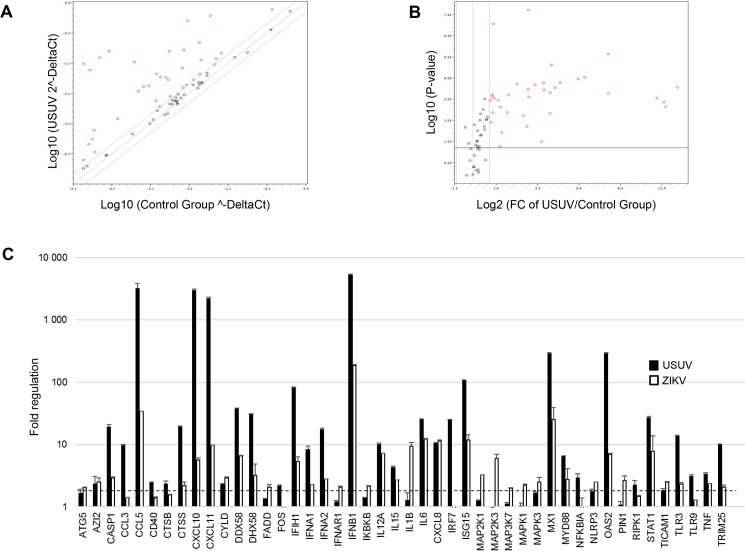
Anti-viral responses in USUV- and ZIKV-infected human astrocytes.mRNA from supernatants of primary human astrocytes infected with USUV or ZIKV at MOI = 1 for 3 days were subjected to qRT-PCR analyses. (A) Scatter plot. Up regulated genes appears in the top-left cadran (boundary 2). (B) Volcano plots, (boundary 2, scatter 0.05: p-values based on student’s t-test of three replicates). Statistically significant changes in fold regulation appear in the top right part of the graph (genes upregulated). The experiment was performed in triplicates and each point represents the mean. (C) Fold regulation of statistically significant genes modulated upon USUV and ZIKV infection are shown. Results are expressed as means ± SD and analyzed using an unpaired t-test *p <0.05.